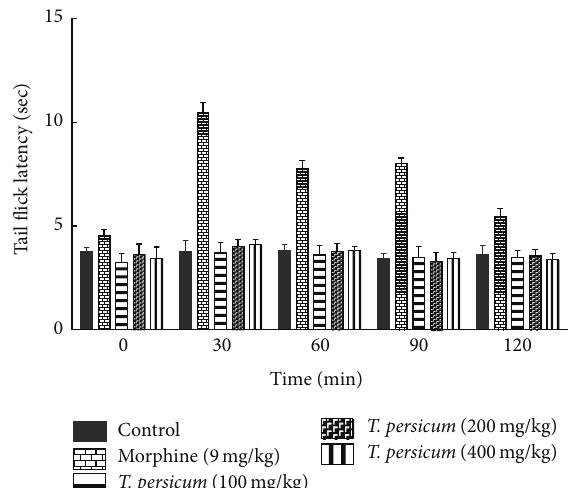
Figure 4: Analgesic effects of plant extract T. persicum Boiss. in test tail jump. ∗ 𝑃 < 0.05 , ∗∗ 𝑃 < 0.01 , and ∗∗∗ 𝑃 < 0.001 significantly different from the control animals ( 𝑛 = 8 ).